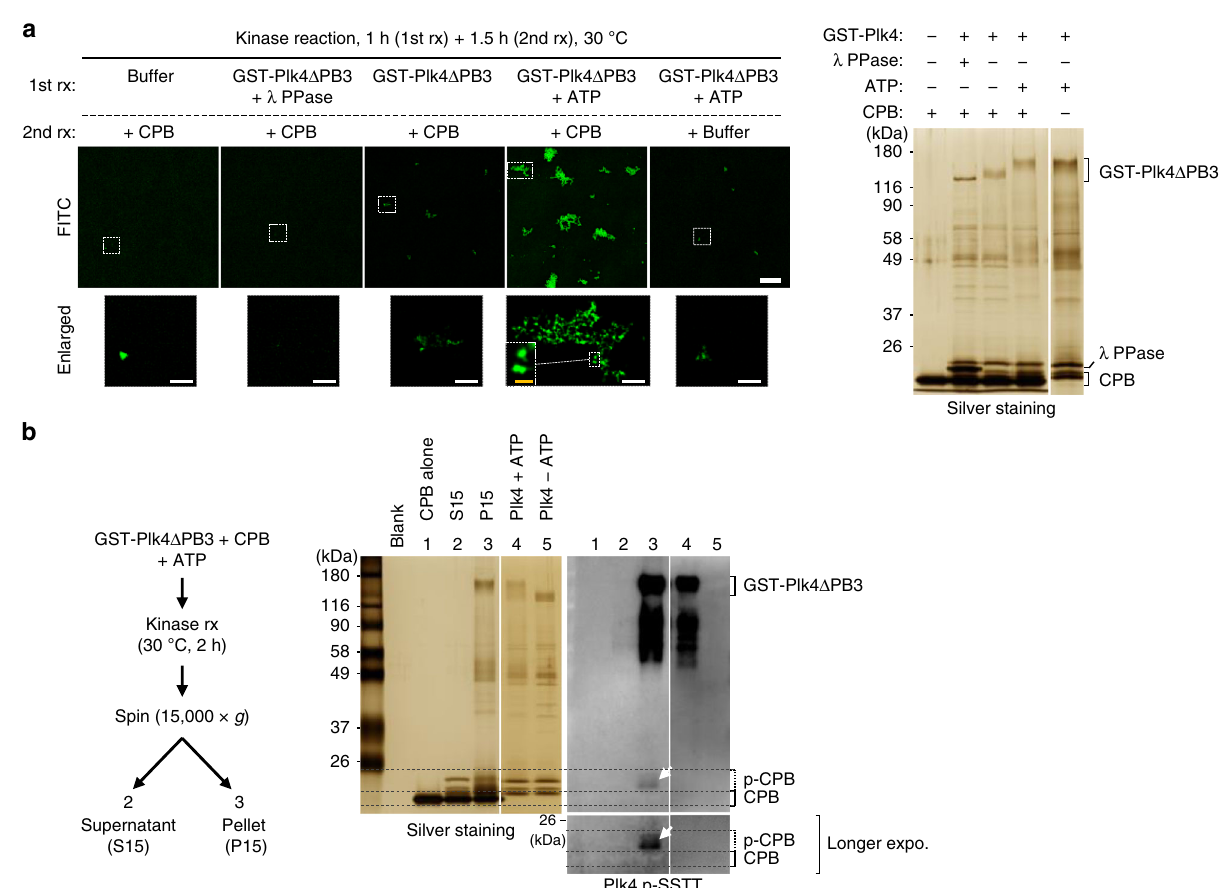
Fig. 7 Phosphorylation of CPB by Plk4 induces clustering in vitro. a 3D-SIM images showing CPB condensates generated by GST-Plk4 Δ PB3-dependent phosphorylation in vitro . Bar, 10 μ m. Dotted boxes, areas of enlargement (bar, 2 μ m). Yellow bar in the dotted box, 0.5 μ m. Kinase reactions were carried out in two steps — Plk4 Δ PB3 activation step (1st rx) and CPB phosphorylation step (2nd rx). Reaction products were decorated with FITC to visualize CPB condensates and imaged (left). The same reaction products were separated by 8% sodium dodecyl sulfate – polyacrylamide gel electrophoresis (SDS- PAGE) for silver staining (right). Note that FITC-decorated condensates contributed by GST-Plk4 Δ PB3 (5th panel) are negligible. b Immunoblotting analysis showing Plk4 Δ PB3-phosphorylated CPB generates pelletable condensates in vitro. Following a kinase reaction, a sample was fractionated into supernatant (S15) and pellet (P15), and then separated by 8% SDS-PAGE. Note that Plk4 Δ PB3-reacted PC3-phosphorylated CPB ( α -pSSTT panel) is present only in the P15 fraction